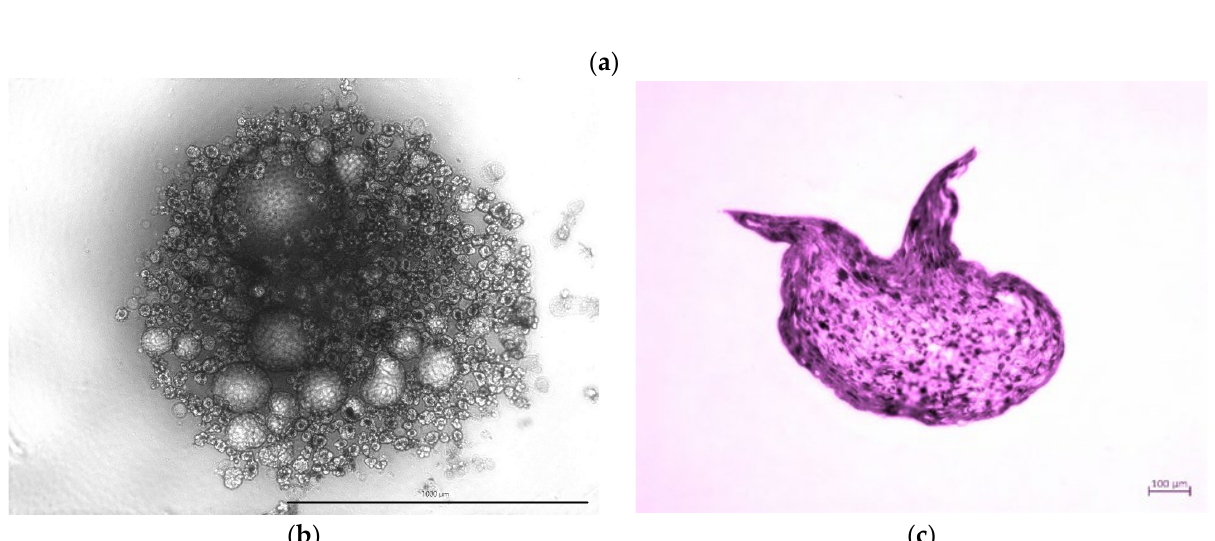
Figure 5. 3D culture under nivolumab treatment. Number of spheroids formed by the RCC30 cell line ( a ). Spheroids formed by the RCC30 cell line under bright field microscopy; the scale bar: 1000 µm ( b ) and after HE staining; the scale bar: 100 µm ( c ) at a concentration of 36 µg/mL nivolumab.